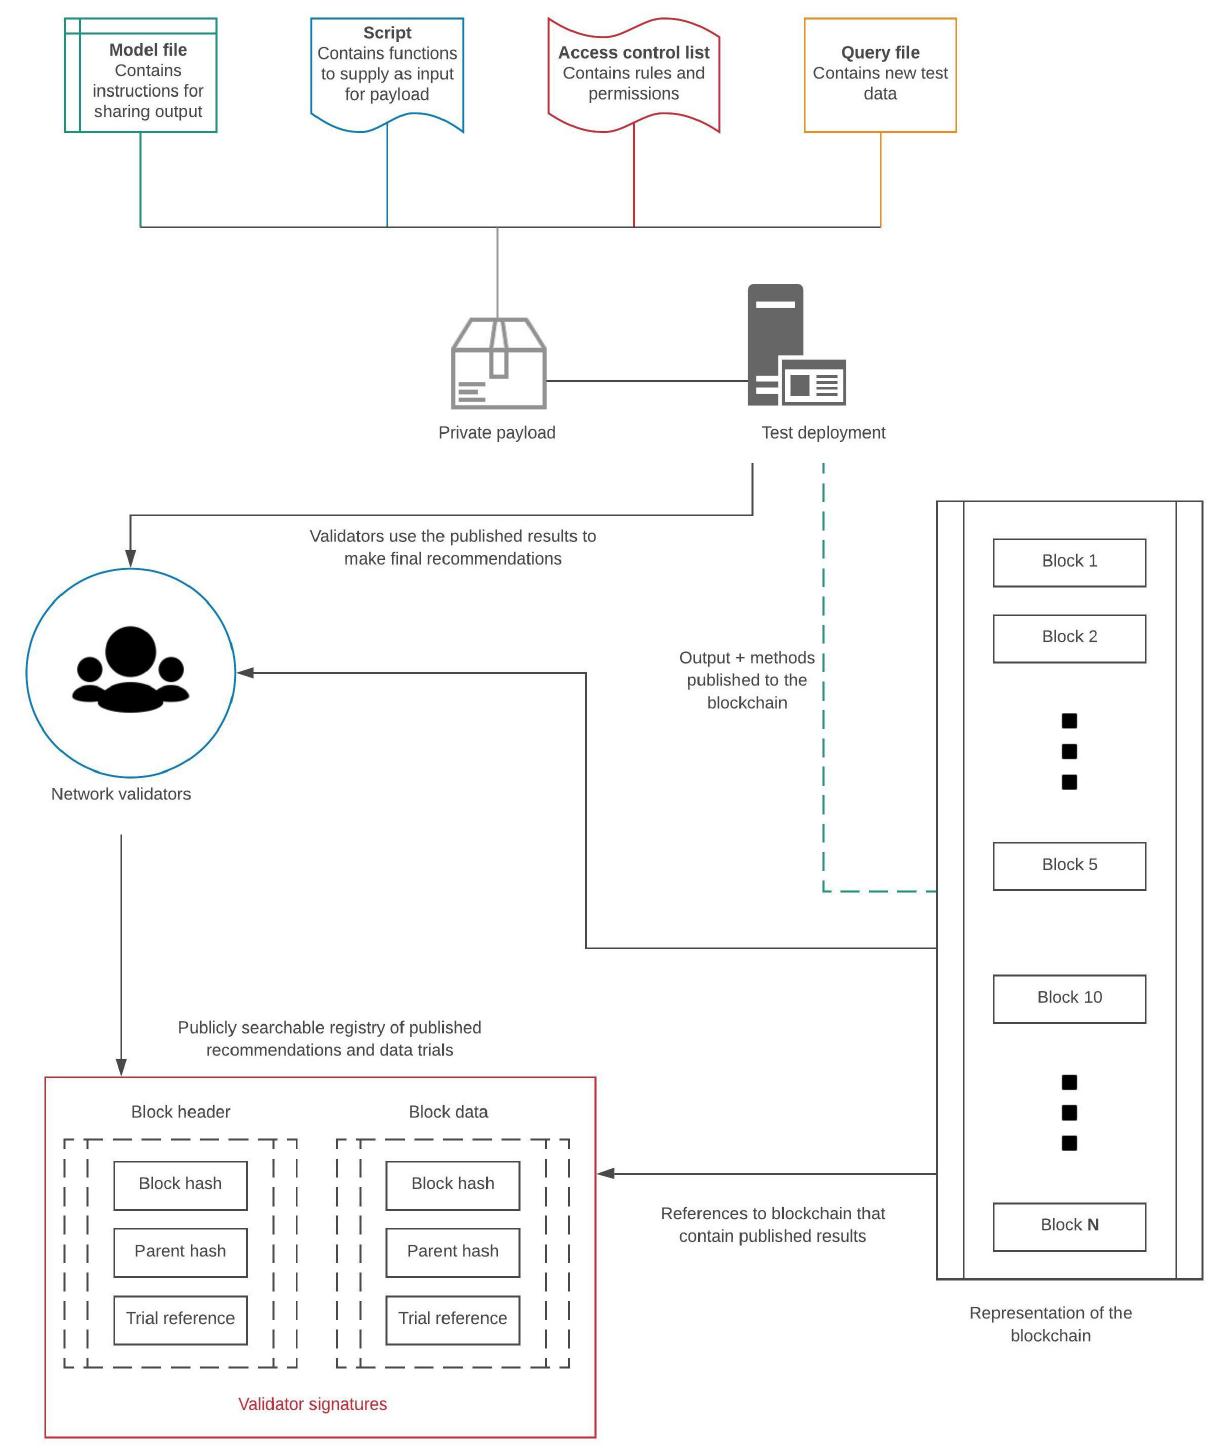
FIGURE 1 | Use-case for blockchain as a peer-review network. The four components dictate how verification of a private payload should be carried out. The model file would have instructions for how to publish the results along with the methods used. The script will dictate how new data is provided to the classifier. The access control list dictates user permissions, and finally, the query file contains new data that can be used to test a private machine learning classifier. The results are published to the blockchain along with a reference to the network validators. The results are reviewed along with the methods by the validators, and final recommendations are published to a publicly searchable registry. This registry serves as a public interface for searchable results that reference specific blockchain instances when the trials were carried out.